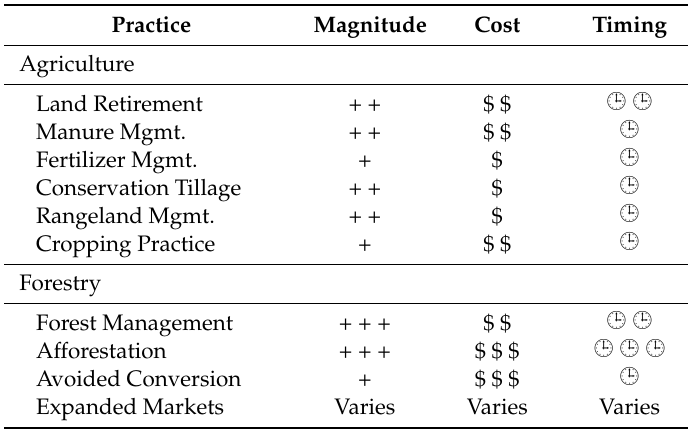
Table 2. Relative magnitude, cost, and timing of select practices to increase GHG mitigation in the U.S. forest and agricultural sectors. The number of symbols in each column provides a relative ranking of practice performance, ranging from low to high (for magnitude and cost) and short to long (for timing). “Varies” indicates substantial range for a practice depending on the details of a particular application.